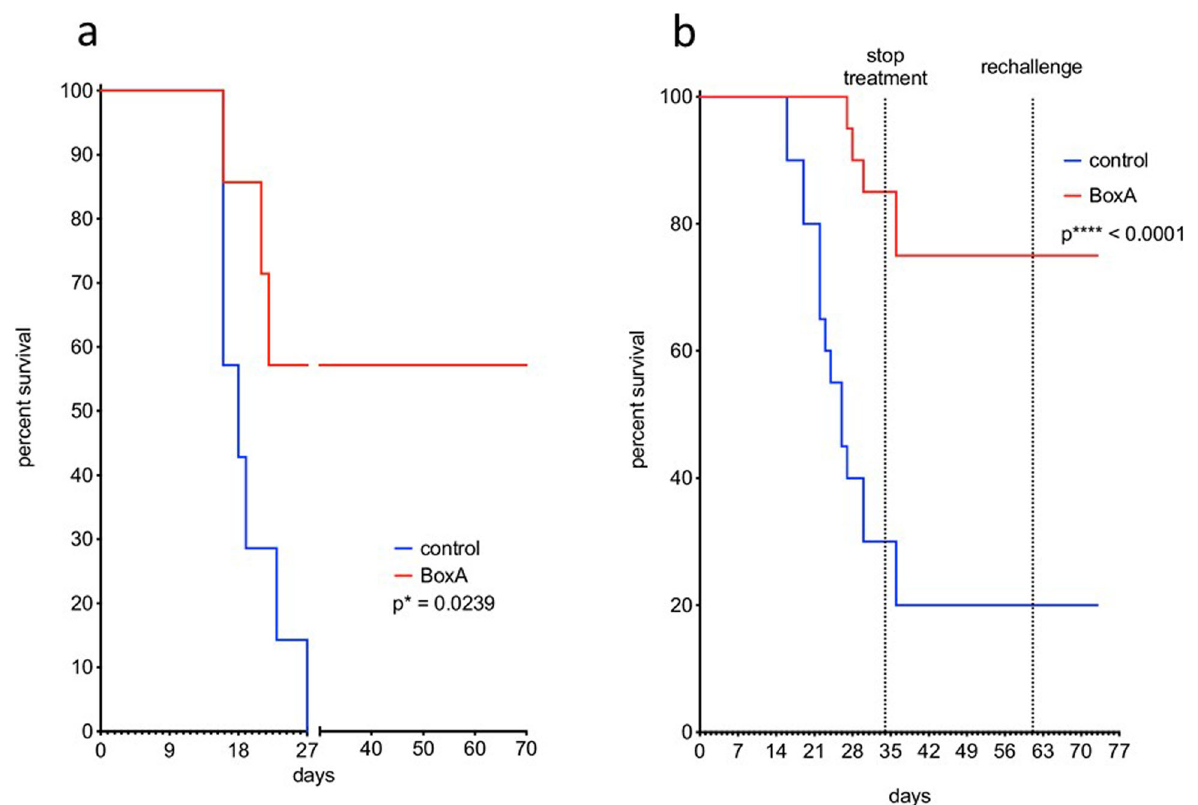
Fig. 1 Mouse survival in the first and second experiments. a The two mouse groups ( n = 7 + 7) of the first experiment were BoxA-treated (red line) and phosphate-buffered saline-treated, i.e. , controls (blue line). Their survival was evaluated up to the 70th day. BoxA-treated mice showed the greatest survival rate: 57.1% at the 70th day after the inoculation of malignant mesothelioma cells. b In the second experiment, the survival curves of controls and BoxA-treated mice were evaluated up to the 34th day after the inoculation and up to day 73 both for rechallenged and non-rechallenged mice: BoxA-treated mice had a highly significant survival rate than controls (same line colors as for panel a